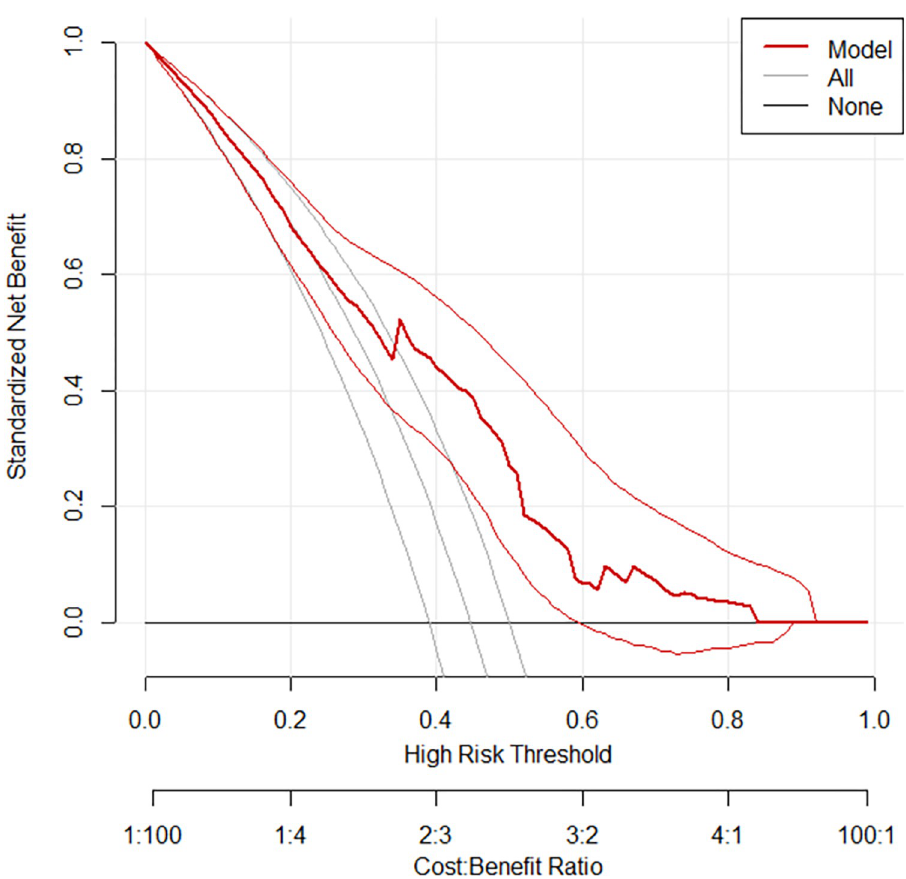
Fig 7. Decision curve plot showing the net benefit of the developed model for carrying out an intervention measure in MDR-TB patients at risk of late culture conversion.